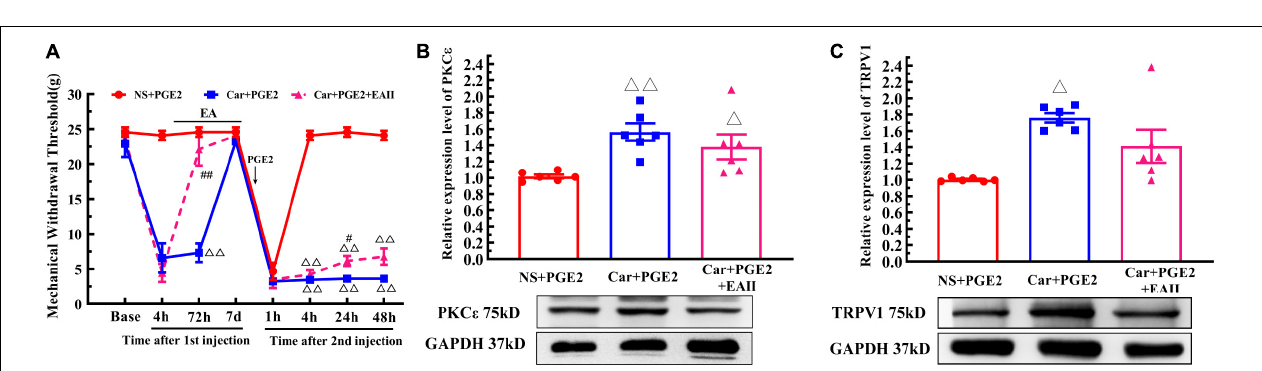
FIGURE 8 | Morphine improves the MWT of hyperalgesic priming rats and inhibits the TRPV1 expression in L4–L6 DRG, but not PKC ε . The protocol of morphine administration (A) . (B) Mechanical responses of hyperalgesic priming model animals to morphine administration. n = 6. Western blot showing PKC ε (C) and TRPV1 (D) protein isolated from the DRG 48 h after PGE2 injection. ## Compared with the Car+PGE2 group, P < 0.01.